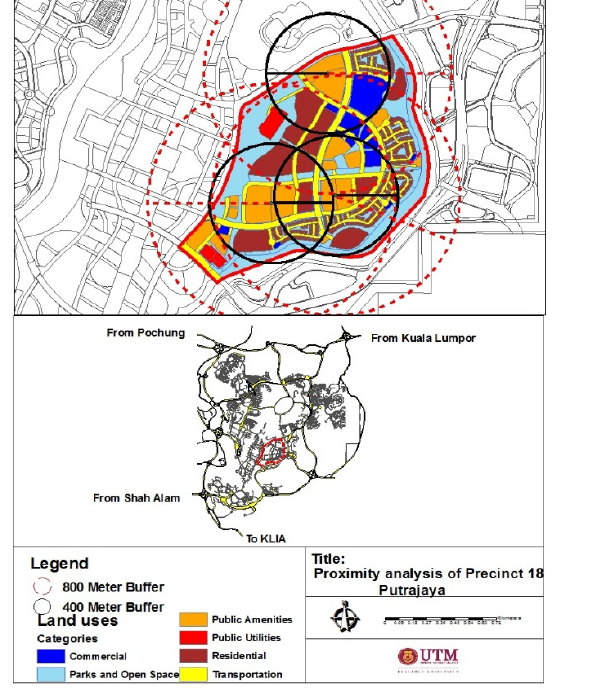
Fig. 3: 400m and 800m radius exploring proximity in highest walkability Precinct 18 [9] Table 5: Public amenities within the range of radius 1, 2, 3 (400 meter) and 4,5,6 (800 meter) Public Amenities